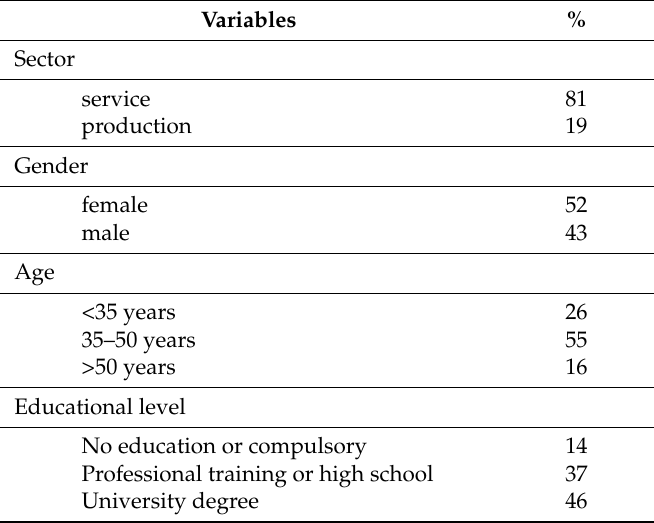
Table 1. Descriptive statistics (demographic